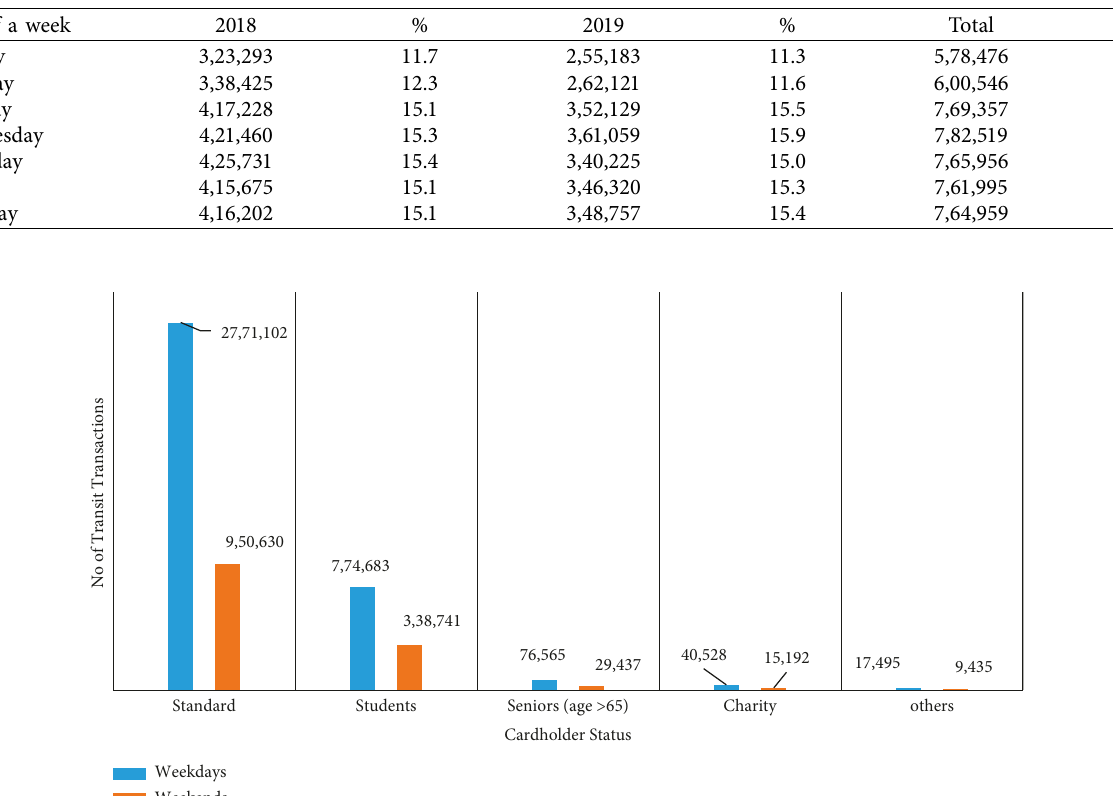
Table 3: Daily transfer distribution from January 2018 to July 2019 in this study.